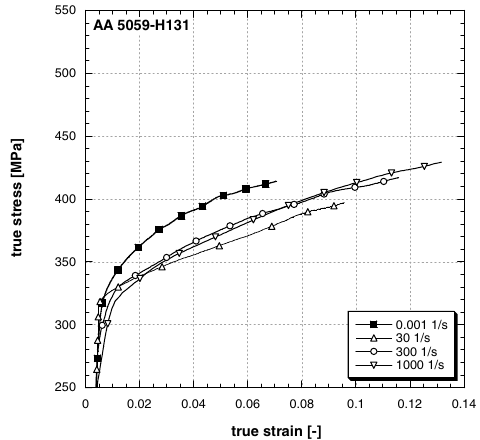
Fig. 8. True stress versus true strain at di ff erent strain-rates for AA 5059-H131.